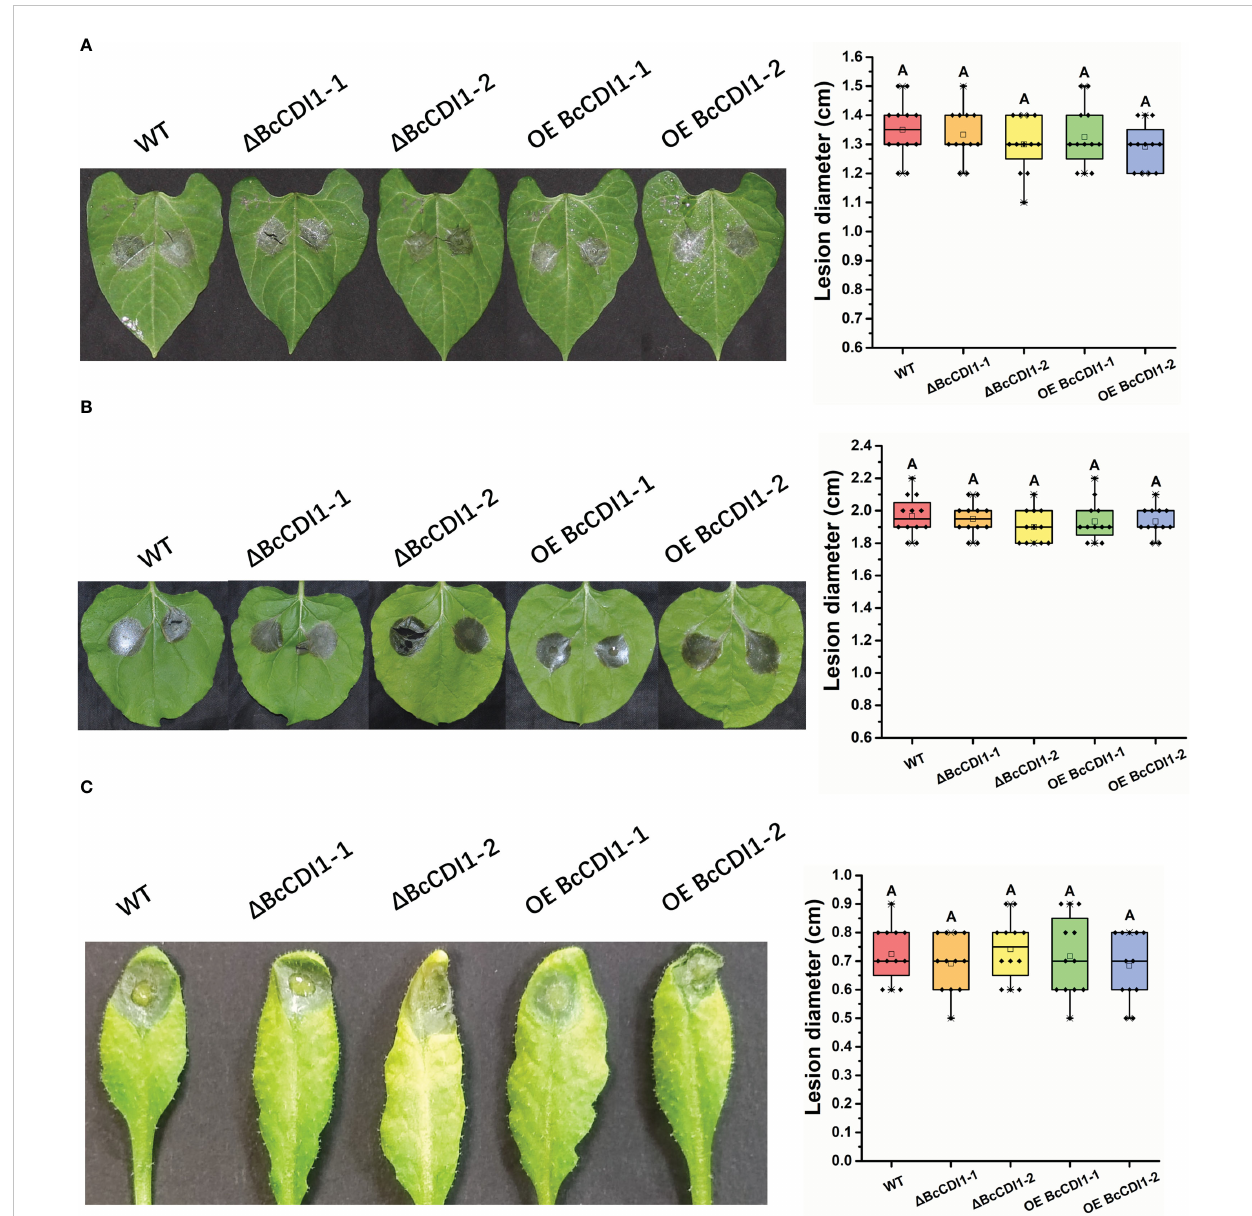
FIGURE 5 Pathogenicity analysis of Botrytis cinerea strain. (A) Bean leaves were inoculated with 7.5 m l of conidial suspension (1 × 10 5 conidia/ml). The plants were incubated in a humid chamber at 22°C for 72 h and photographed, and the lesion size was determined. (B) Tobacco leaves were inoculated with 7.5 m l of conidial suspension (1 × 10 5 conidia/ml). (C) Arabidopsis thaliana leaves were inoculated with 7.5 m l of conidia suspension (1 × 10 5 conidia/ml). The plants were incubated in a humid chamber at 22°C for 72 h and photographed, and the lesion size was determined. Data were obtained from three independent experiments, with four replicates in each experiment. In box plots, whiskers indicate the minimum and maximum values, the line indicates the median, and the box boundaries indicate the upper (25th percentile) and lower (75th percentile) quartiles. All data are plotted as black dots. Similar letters in the graph indicate no statistical differences at P ≤ 0.01 using ANOVA (one-way) followed by Tukey ’ s post-hoc